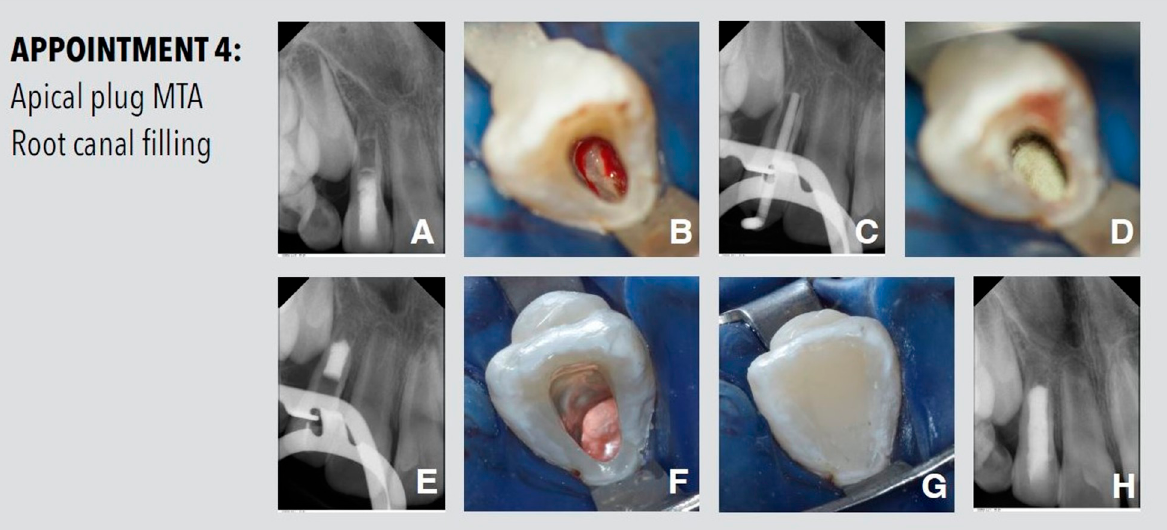
Figure 4. Procedures performed at the fourth appointment. ( A ) Periapical radiograph. ( B ) Hard tissue barrier was clearly visible under the operating microscope. ( C ) Radiographic working length determination with gutta-percha point. ( D ) Apical plug with MTA. ( E ) Radiologic view of the apical MTA plug up to the apical hard tissue barrier. ( F ) Obturated root canal using a warm vertical gutta-percha and sealer up to 3 mm below the cement–enamel junction (CEJ). ( G ) Sealed cavity with bonded composite resin. ( H ) Periapical radiograph of the root filled tooth.